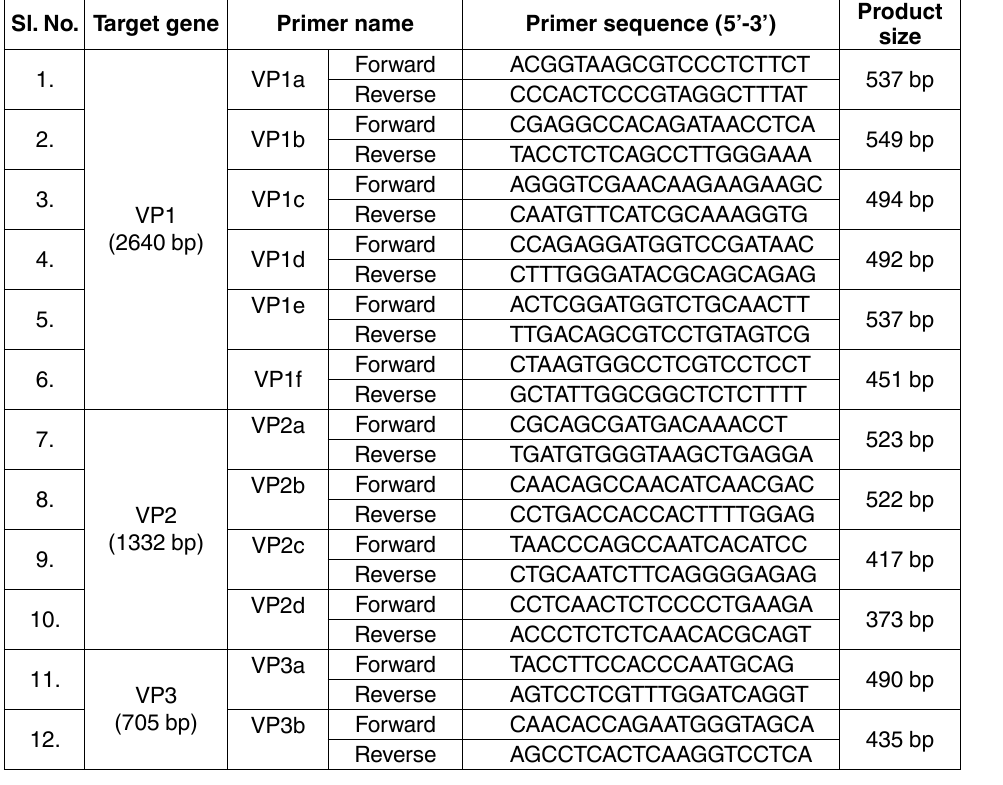
table 2. Details of primers targeting VP1, VP2 and VP3 genes sl. No. target